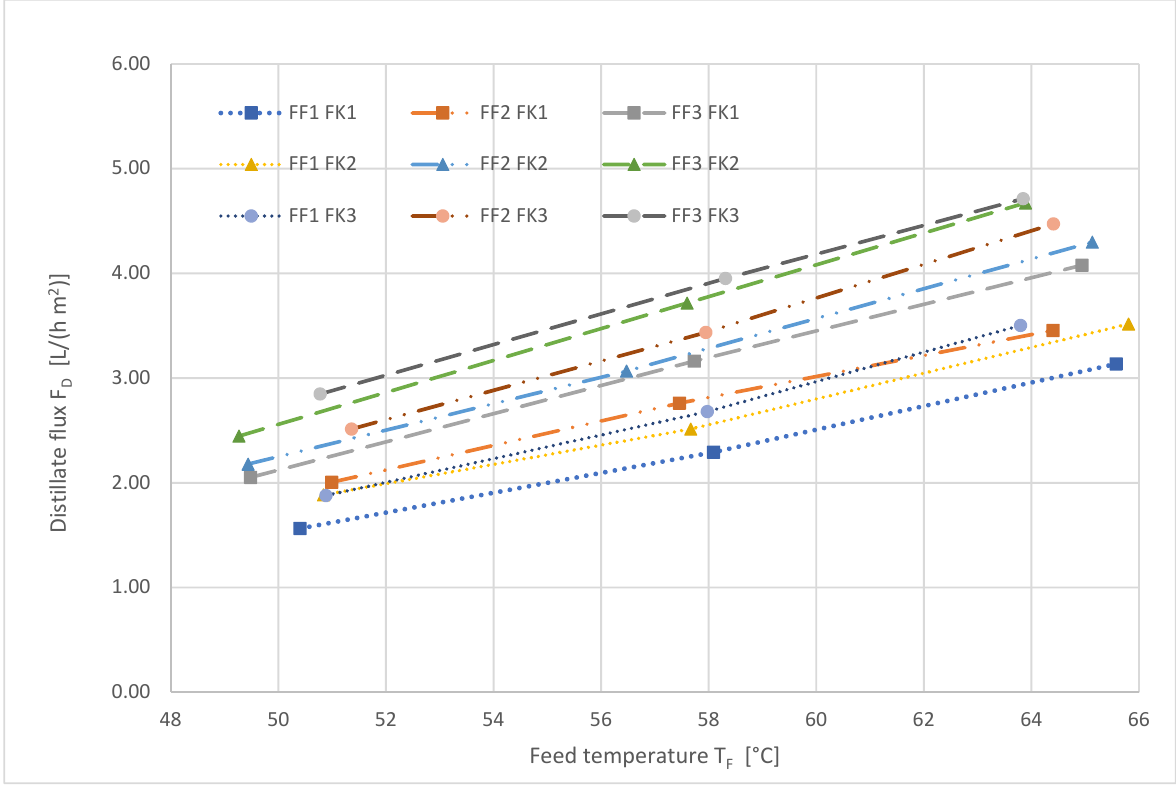
Figure 4. Distillate flux as a function of the feed temperature during AGMD at a constant cooling water temperature of 17.5 °C. The numbers refer to the different levels, low (1), medium (2) and high (3), described in Table 4.